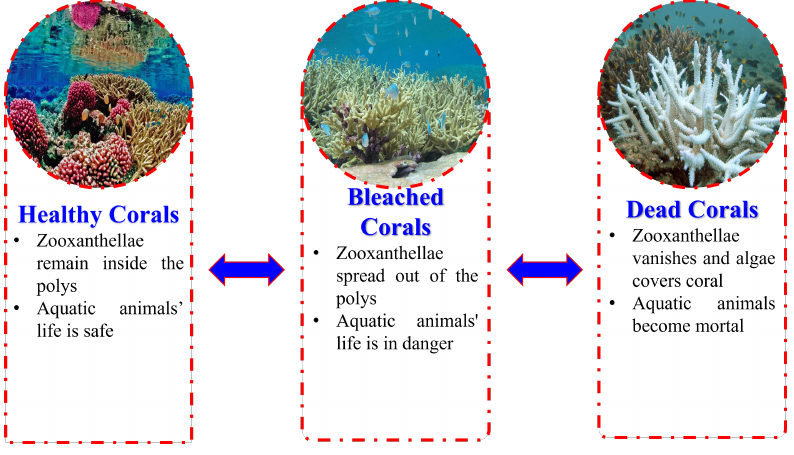
Figure 1. Different types of corals and their impact on aquatic